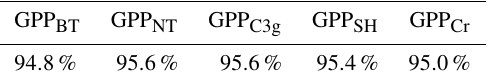
Table 3. A table of the accuracy rates of each of the 5 PFT-specific emulators. A perfect emulator would have an accuracy rate of 95 . 4%; larger values imply underconfidence, smaller values imply